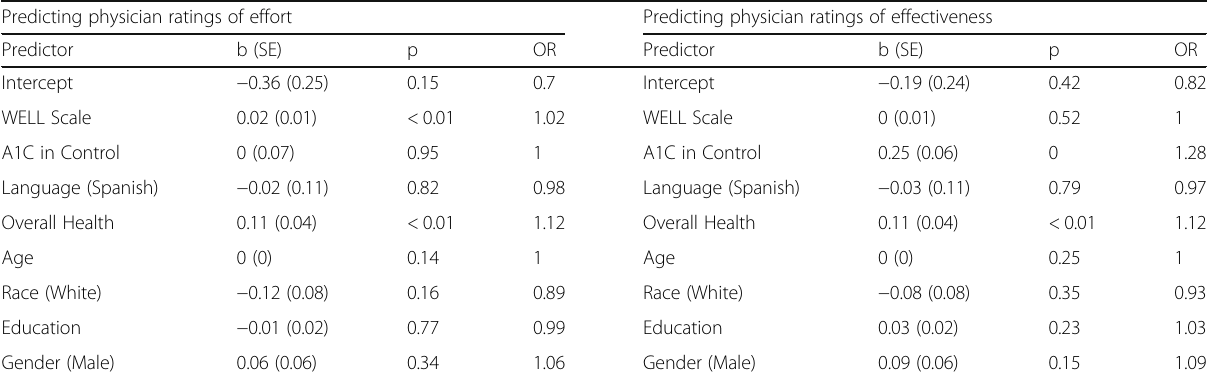
Table 5 Predicting physician ratings of effort and effectiveness Predicting physician ratings of effort Predicting physician ratings of